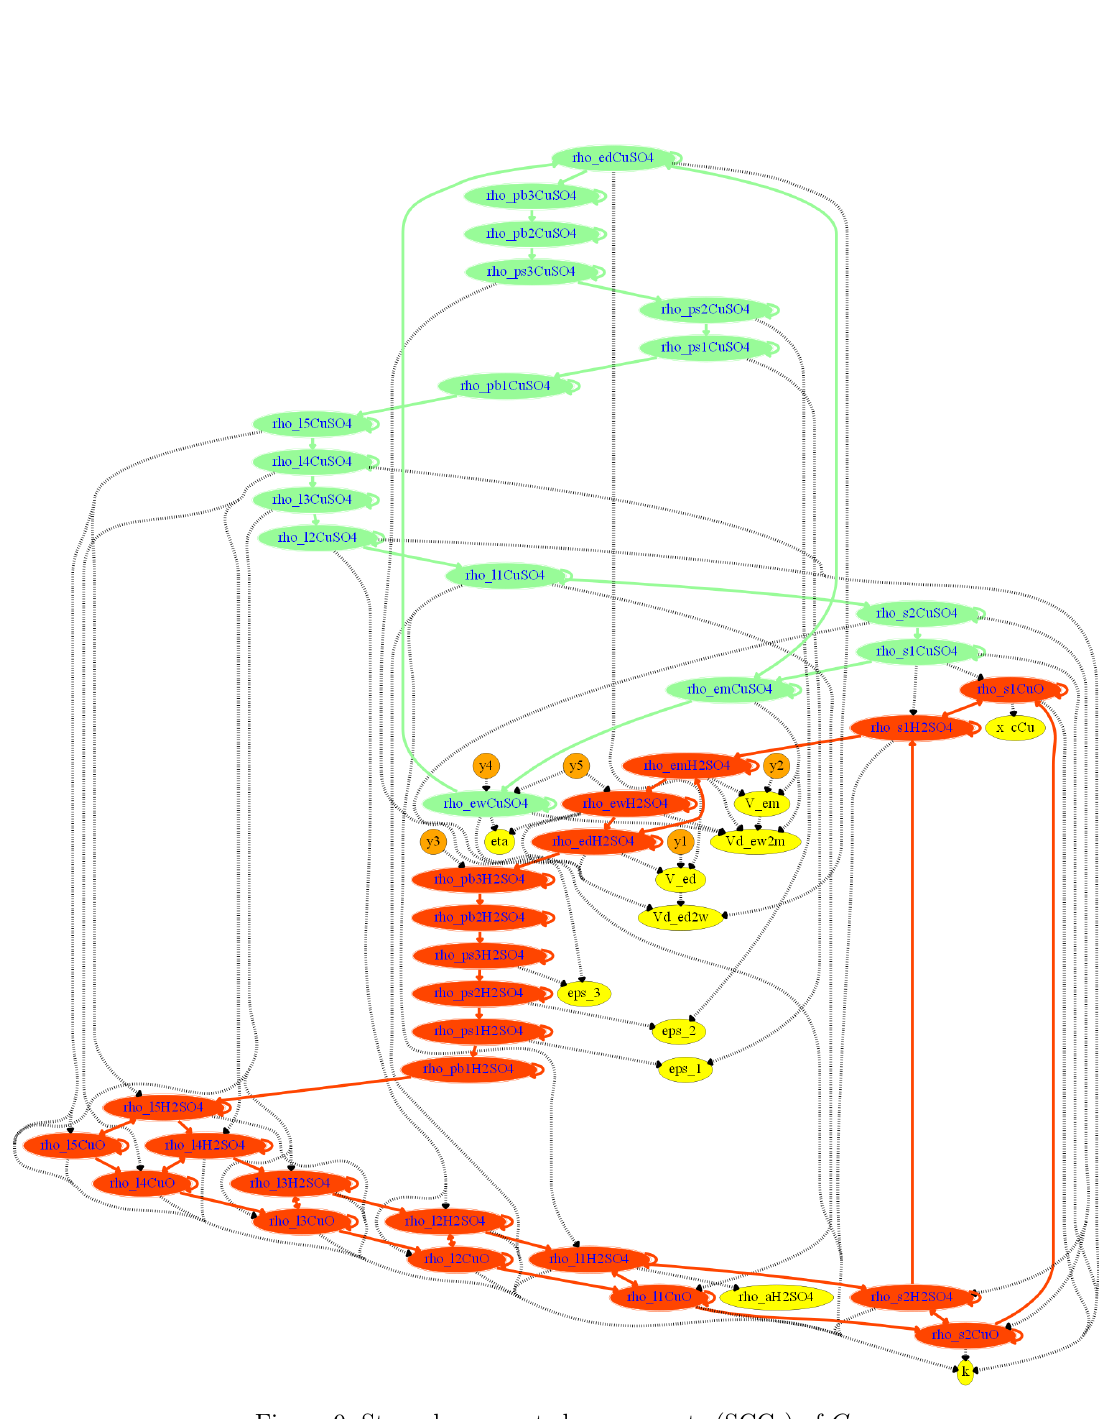
Figure 9: Strongly connected components (SCCs) of G